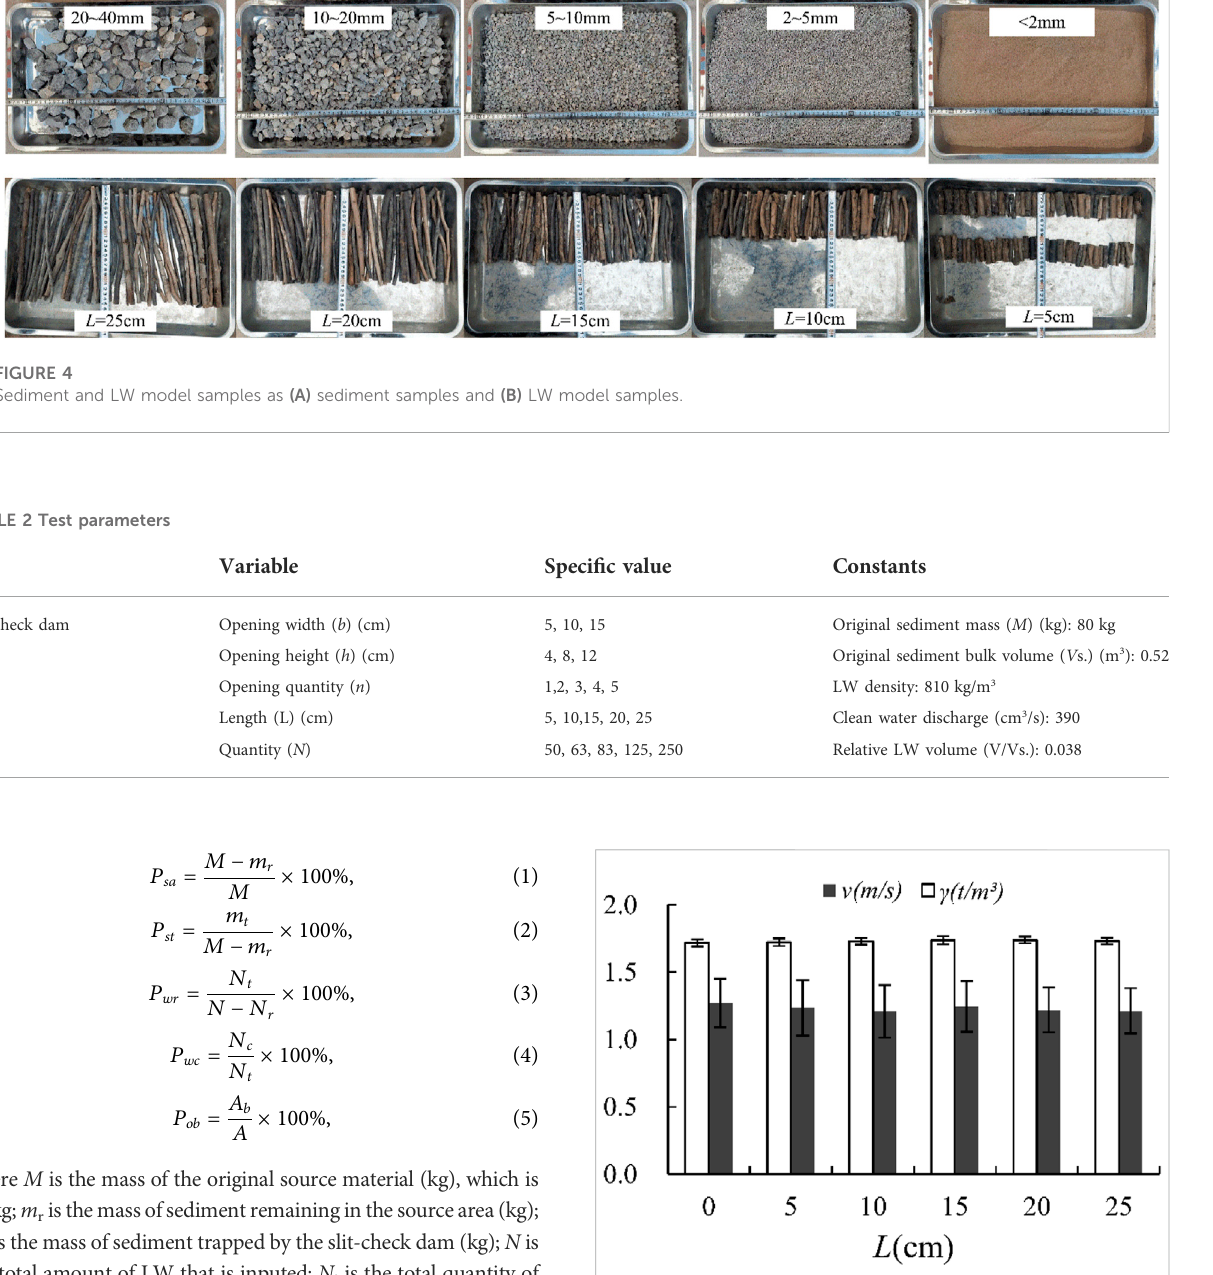
FIGURE 5 Density and velocity of debris fl ows under different